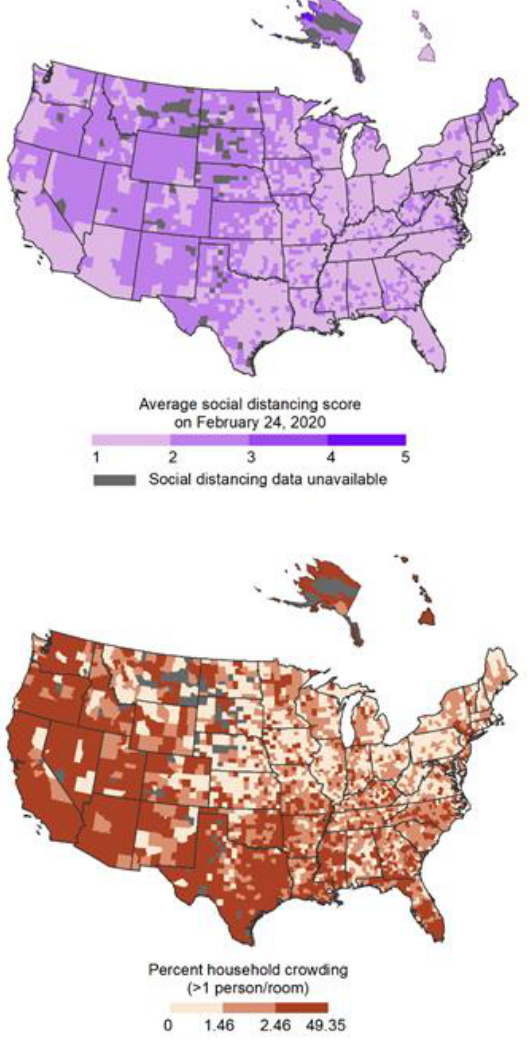
Figure 1. County-level objective social distancing and percent household crowding in the U.S. Social distancing was mapped based on the Unacast scoring scheme and household crowding was mapped using tertiles based on all 3054 counties in the analysis.